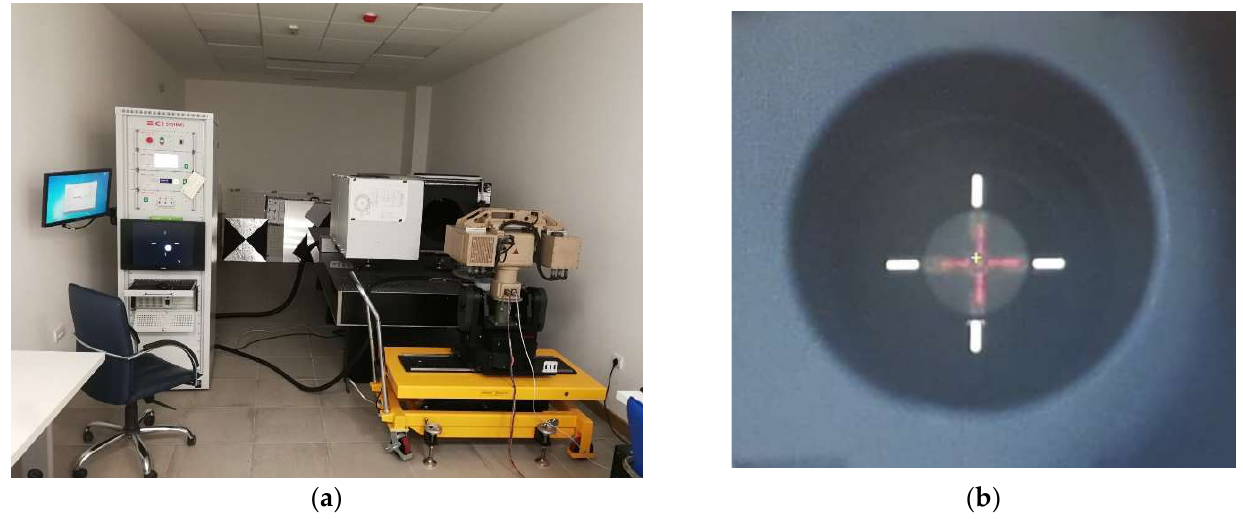
Figure 5. Calibration procedure in Vlatacom electro-optical laboratory ( a ) and alignment of camera axes and laser beam ( b ).